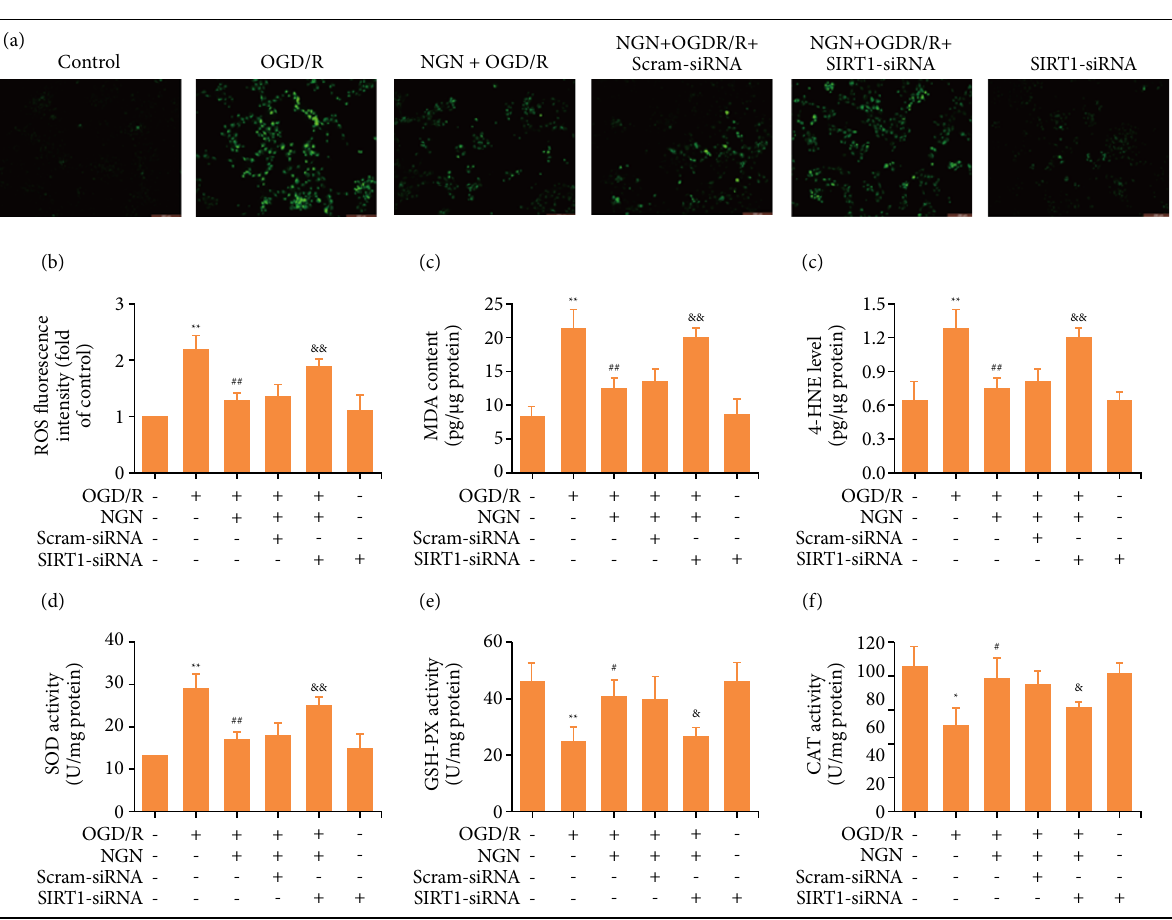
Figure 5 – Effects of SIRT1-siRNA transfection on the inhibition of naringenin on oxidative stress in OGD/R-subjected HT22 cells. After transfection with SIRT1-siRNA(50 nmol·L –1 ) or scrambled siRNA (50 nmol·L –1 ) for 6 h, HT22 cells were treated with naringenin (80 μ mol·L –1 ) for 2 h followed by treatment with OGD (6 h)/R (24 h). (a) ROS generation was calculated by DCFH-DA staining and (b) quantitative analysis of ROS fluorescence by flow cytometry; (c) MDA content; (d) 4-HNE level; (e) SOD activity; (f) GSH-Px activity, and CAT activity was determined by MDA assay kit, 4-hydroxynonenal ELISA kit, SOD assay kit, glutathione peroxidase (GSH-Px) assay kit, and CAT assay kit, respectively. Data were expressed as mean ± SD from three independent experiments. * P < 0.05, ** P < 0.01 vs. control group; # P < 0.05, ## P < 0.01 vs. OGD/R group; & P < 0.05, && P < 0.01 vs. NGN + OGD/R +Scram-siRNA group. NGN: naringenin; OGD/R: oxygen-glucose deprivation/reperfusion. Blockage of SIRT1 signaling pathway reverses the inhibition of naringenin on OGD/R-induced inflammatory response in HT22